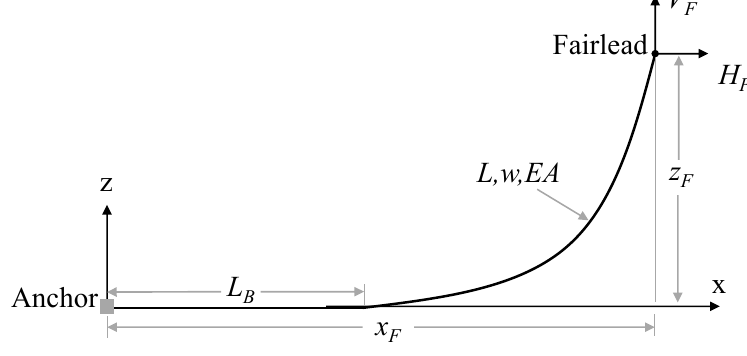
Figure 2. Local coordinate system of the mooring lines.